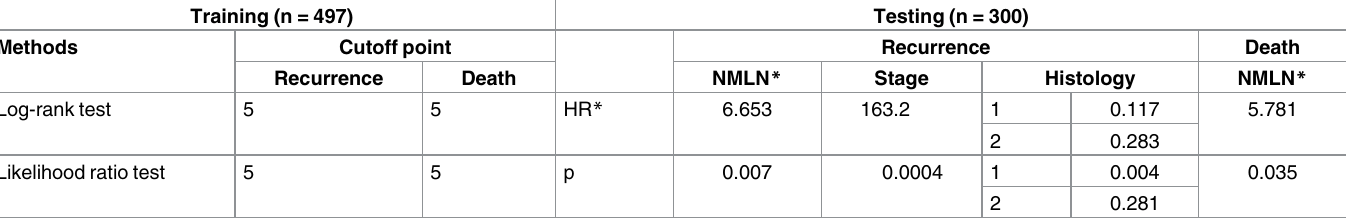
Table 2. Optimal cutoff point: Total number of lymph node metastasisvs.